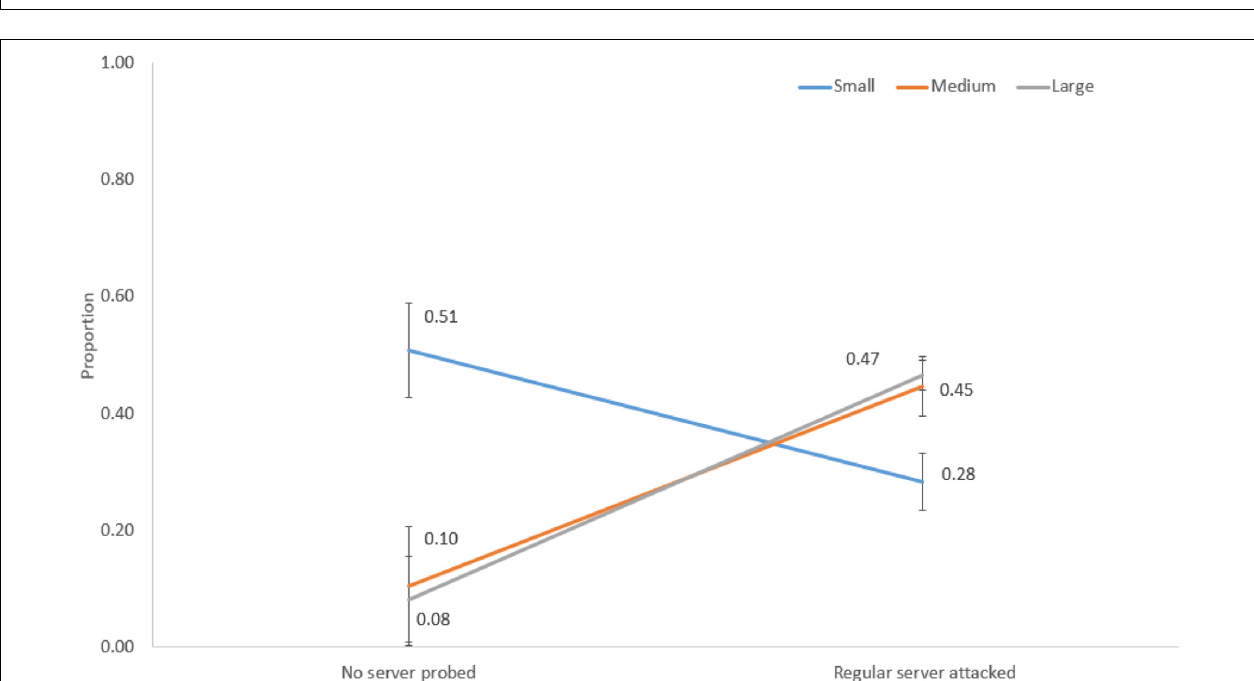
FIGURE 10 | The proportions of no server probed and regular server attacked decisions in different network sizes.